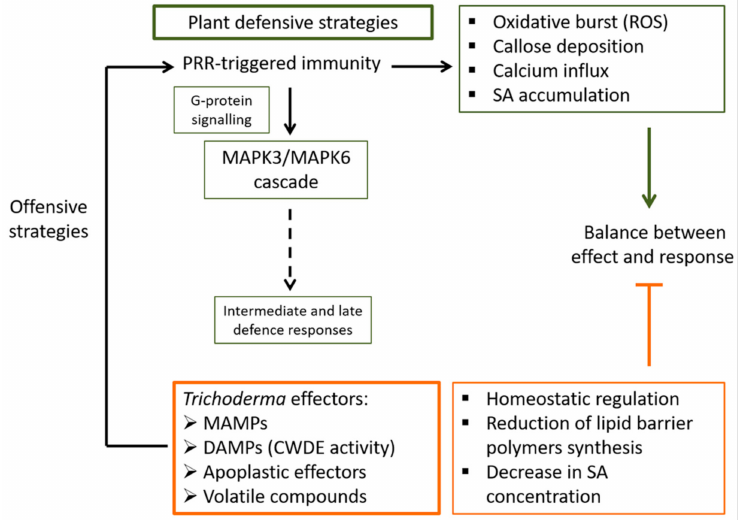
Figure 1. Schematic outline of plant’s early response to the interaction with Trichoderma. Plant ´ s cell surface pattern recognition receptors (PRR) are the first line of defence against Trichoderma effectors during the early response (this first stage of the colonization being considered by the plant as an attack). As a result of this first encounter between the plant and Trichoderma , a series of events will be triggered in the plant including the rapid release of reactive oxygen species (ROS), the deposition of callose, calcium influx, and accumulation of salicylic acid (SA) at the primary inoculation site as well as for systemic defence. Another one of the early events triggered by PRR stimulation is the activation of the mitogen-activated protein kinases (MAPK) cascade mediated by the G-protein complex, which will lead to several intermediate and late defence responses. Trichoderma spp. will find their way to balance this early plant response into one of mutual benefit by regulating homeostasis and reducing the synthesis of plant lipid barrier polymers, as well as by decreasing the production of